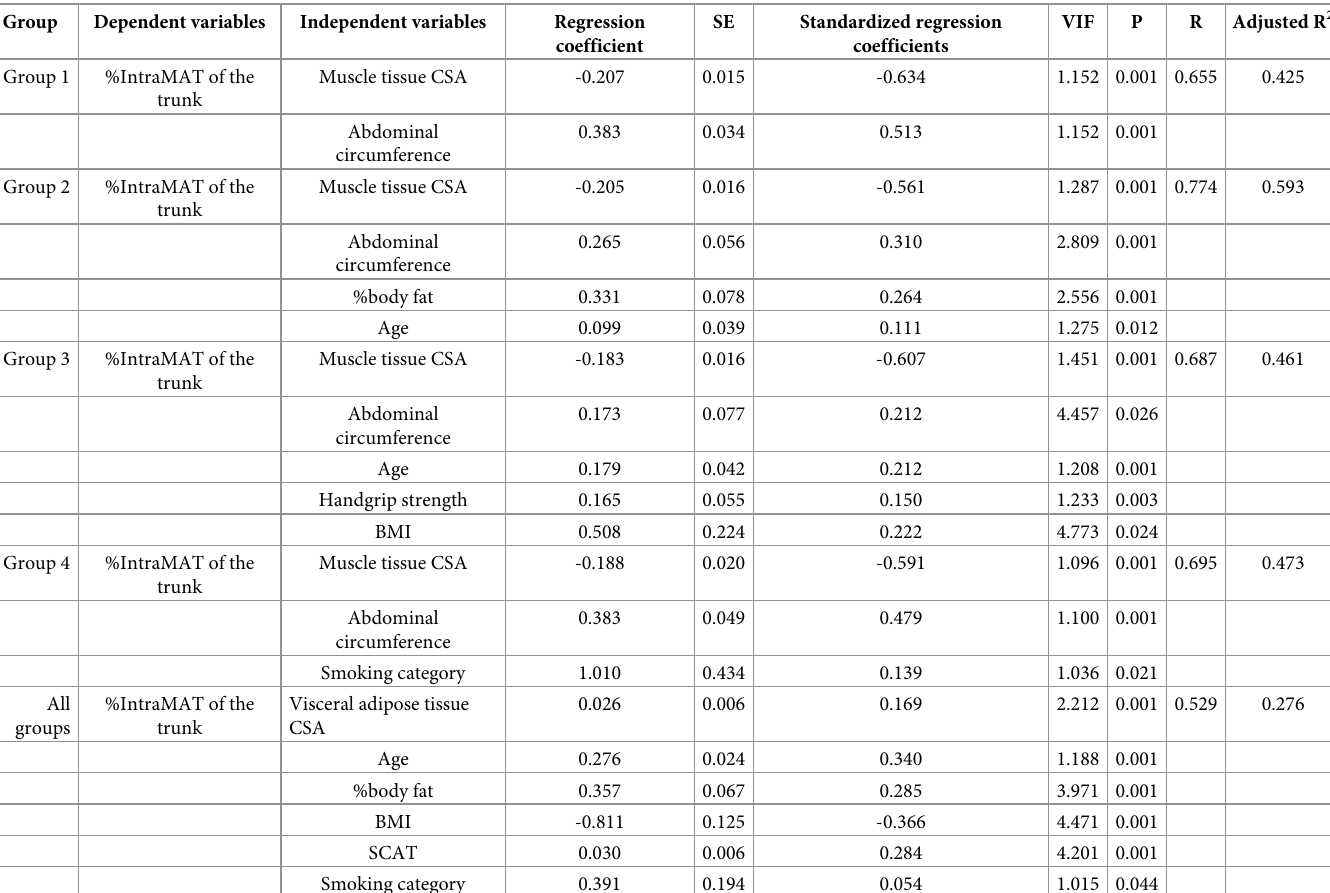
Table 3. Stepwise linear regression analysis as a dependent variable of %IntraMAT of the trunk muscle. Group